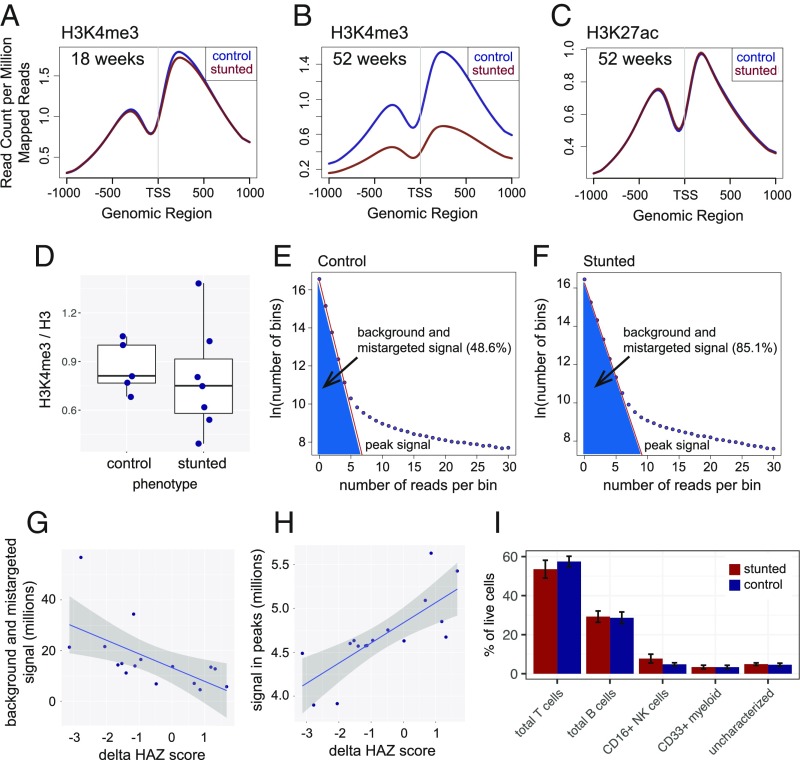
Global change in H3K4me3 in control and stunted children at 1 y of age. (A and B) Gene average plots of histone H3K4me3 levels with respect to TSS at 18 and 52 wk of age in control and stunted children. Stunted children were phenotypically defined by HAZ score < −2 at 1 y of age. The TSS methylation difference at 1 y of age is highly significant (P < 2.2e-16 by Wilcoxon rank sum test). (C) Gene average plot of H3K27ac levels in control and stunted children at 52 wk of age. (D) Total histone H3K4me3 relative to total histone H3 in 1-y-old control and stunted children determined by Western blotting. Each dot represents the H3K4me3/H3 ratio in an individual child’s PBMC chromatin sample. (E and F) Representative read distributions across the genome. The plots show the number of reads per 150-bp bin (x axis) versus the logarithm of the number of bins (y axis) with the indicated read count for a dataset from a control child and a dataset from a stunted child, both at 1 y of age. Background plus mistargeted read counts were calculated from the linear fit of bins using an exponential distribution background model (as detailed in Methods) with the lowest read counts (red lines; typically zero to nine reads per bin, optimized for each dataset). (G) Relationship between background plus mistargeted signal (calculated as in E and F) and ∆HAZ score. (H) Relationship between H3K4me3 signal in peaks and ∆HAZ score. In G and H, linear fits of the data are shown in blue with SE indicated by shading. (I) PBMC cell subpopulations in control and stunted children from age 53 wk. Percentages were calculated by manual gating of flow cytometry data. Data are a summary of 8 stunted and 11 nonstunted children. Bar positions represent the mean and error bars indicate SE.